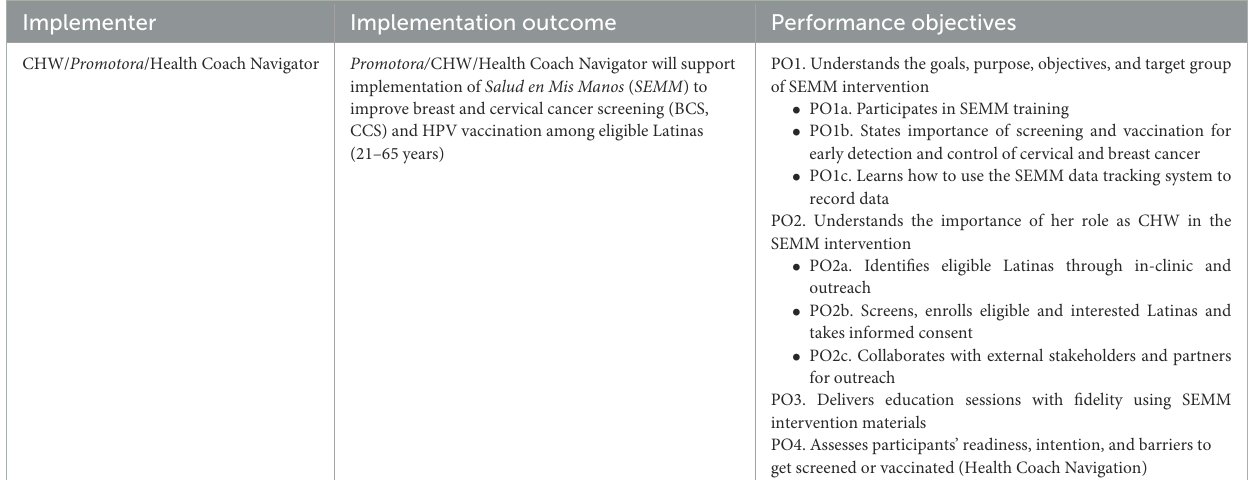
TABLE 3.3 Implementation outcomes and performance objectives: Promotora /CHW/Health Coach Navigator level (example).